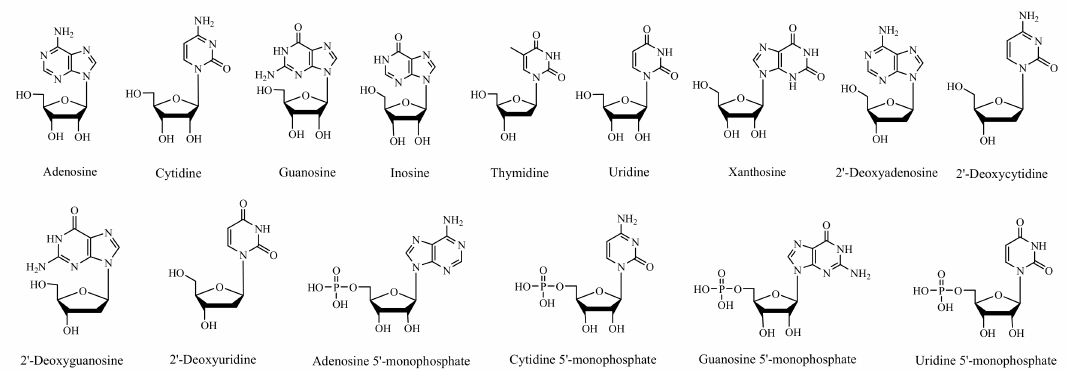
Figure 1. Chemical structures of 15 nucleic acid